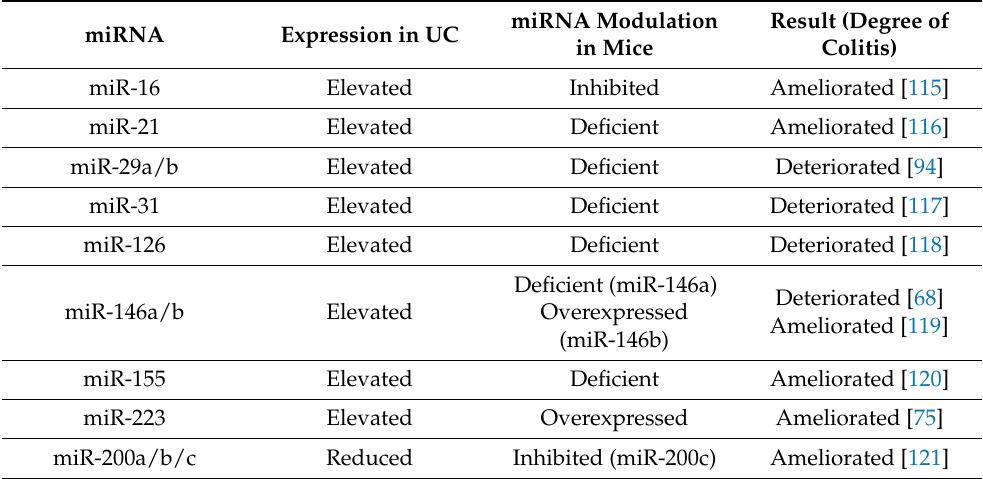
Table 2. Role of UC-associated miRNAs in dextran sodium sulfate (DSS)-induced acute colitis.